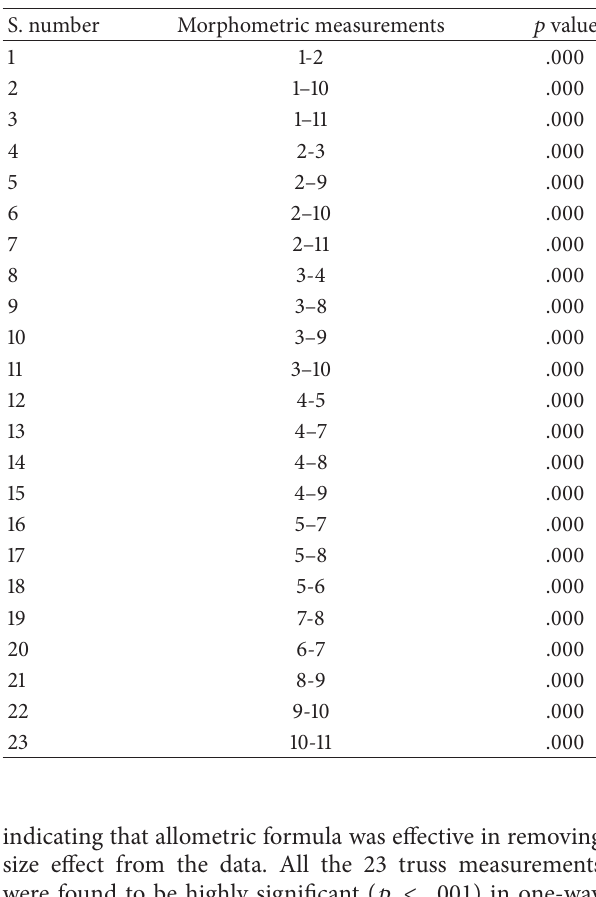
Table 1: Highly significant ( 𝑝 < .001 ) 23 truss measurements between the three subpopulations of C. punctatus in one-way ANOVA